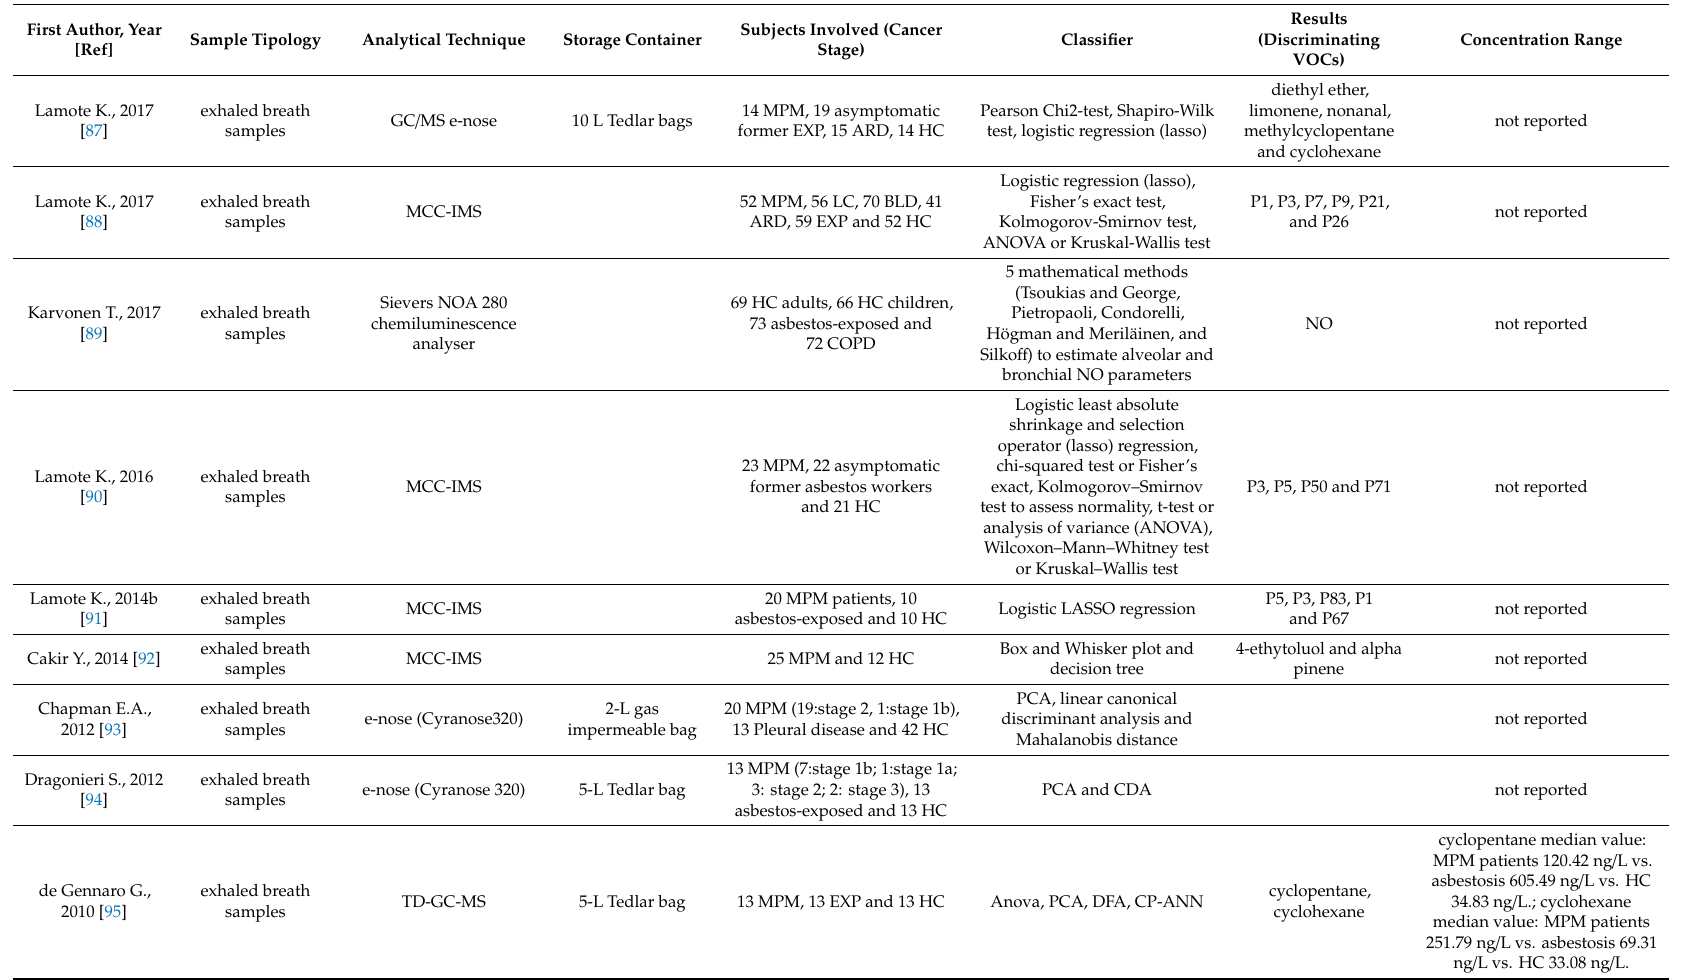
Table 1. Overview of experimental design, applied methodology and population characteristics of selected